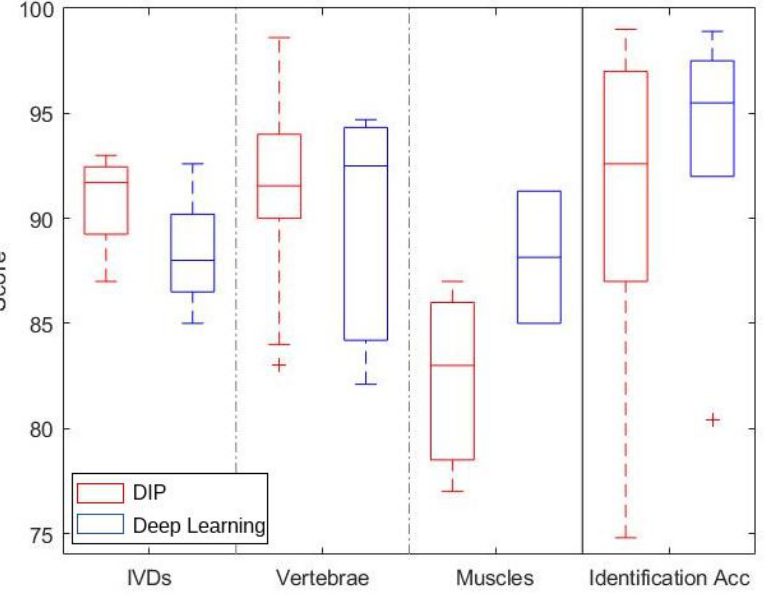
Figure 4. Boxplot summarizing the results for different structures and tasks. The three left columns refer to the DICE scores for the segmentation of IVDs, vertebrae and muscles; the right column refers to the identification accuracy for different